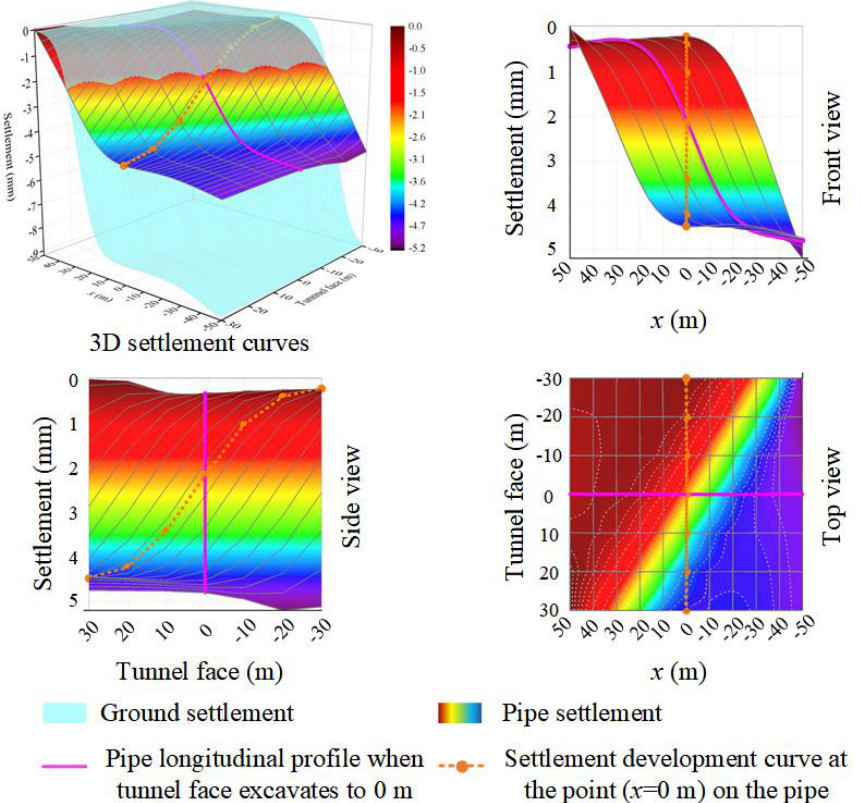
Figure 17. Three-dimensional deformation with shield tunnel construction and grouting processes.